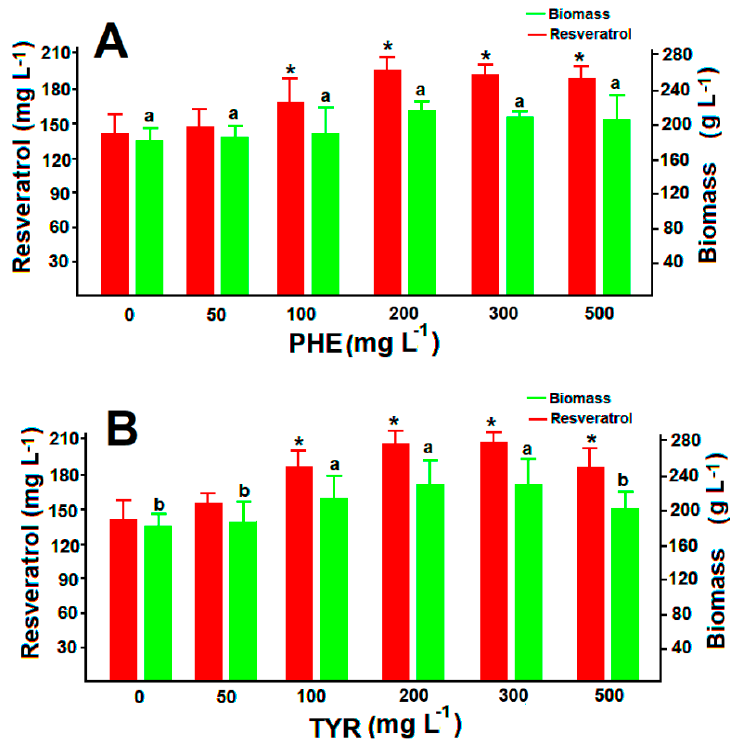
Figure 4. Production of RV and biomass by the addition of different concentrations of PHE ( A ) and TYR ( B ) to batch cultures of Arcopilus aureus MaC7A analyzed at 7 days post-treatment. * Indicates statically significant differences ( p < 0.05) for RV production compared with the control group (0 mg L − 1 ). Means with different letters indicate statistically significant differences among the biomass and amino acid concentrations ( p < 0.05). Error bars represent SD (n =